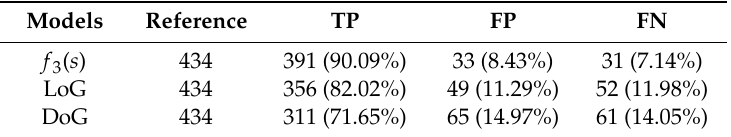
Figure 13. The Laplacian of Gaussian (LoG) technique ( a ), the Di ff erence of Gaussian (DoG) technique ( b ), and ( c ) the discrete Gaussian scale space using f 3 ( s ) for the walnut tree orchard. Table 3. Detected tree objects based in f 3 ( s ) model, Laplacian of Gaussian (LoG), and Di ff erence of Gaussian (DoG) for walnut tree.